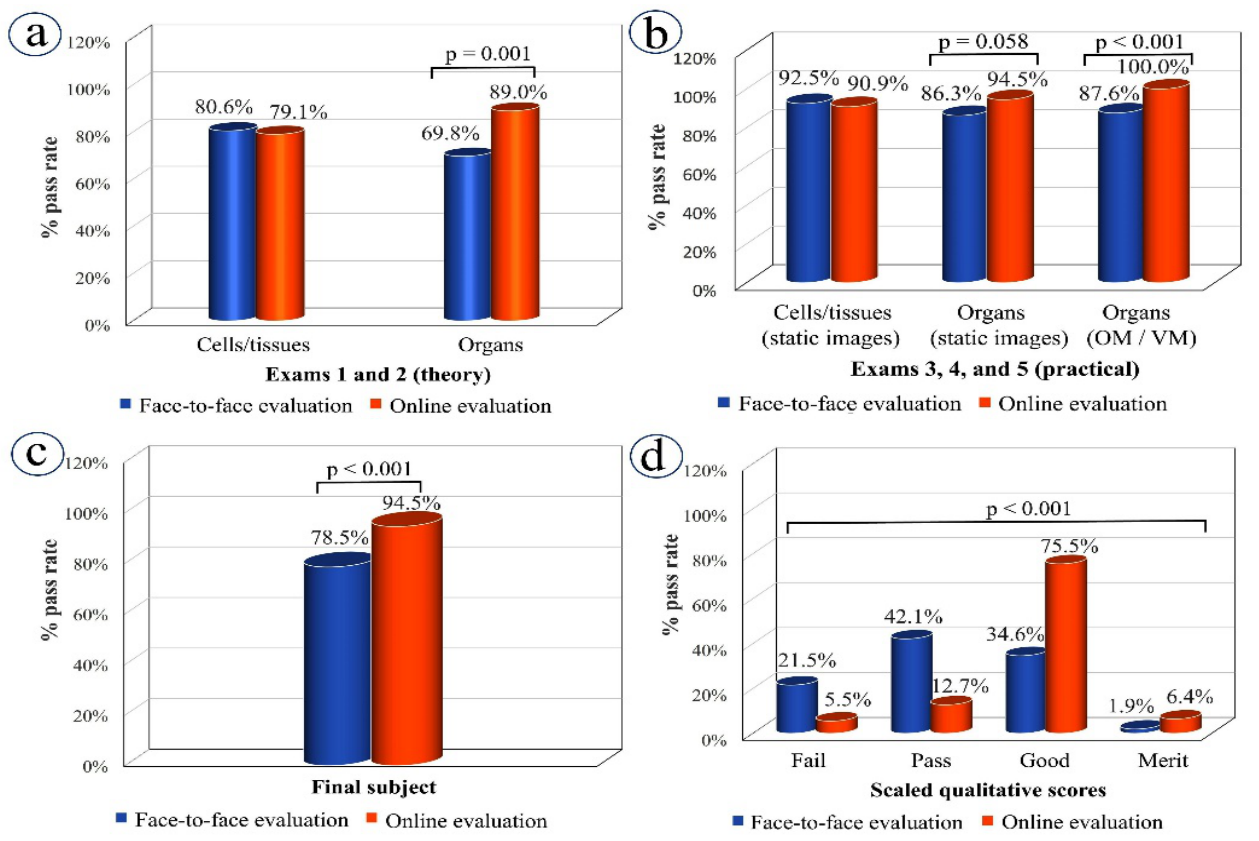
Figure 4. Students’ outcomes: a comparison between the 2018–2019 cohort examined in-person and the 2019–2020 lockdown cohort examined online. ( a ) Percentages of students passing the two theoretical exams (exams 1 and 2); ( b ) Percentage of students passing the three practical exams (exams 3, 4, and 5); ( c ) Percentage of overall passes in the cytology and histology course; ( d ) Percentages of final scaled qualitative scores for both student cohorts. Fisher’s exact test ( a – c ) and Chi-square test ( d ) were applied. OM, optical microscopy; VM, virtual microscopy.